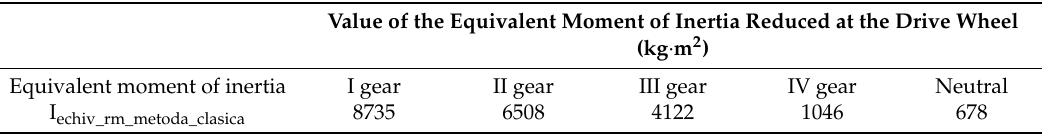
Table 3. Equivalent reduced moment of inertia at the drive wheel determined using the classical gravitational method.